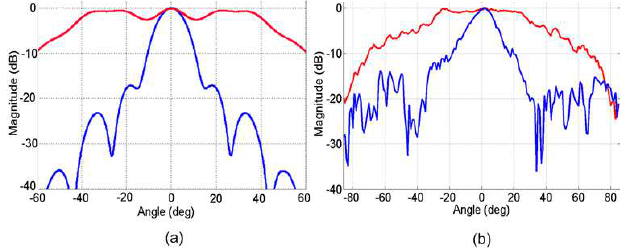
Figure 5: (a) Calculated and (b) measured radiation pattern at 10.6 GHz of the proposed metamaterial antenna (blue) and the microstrip patch radiator alone